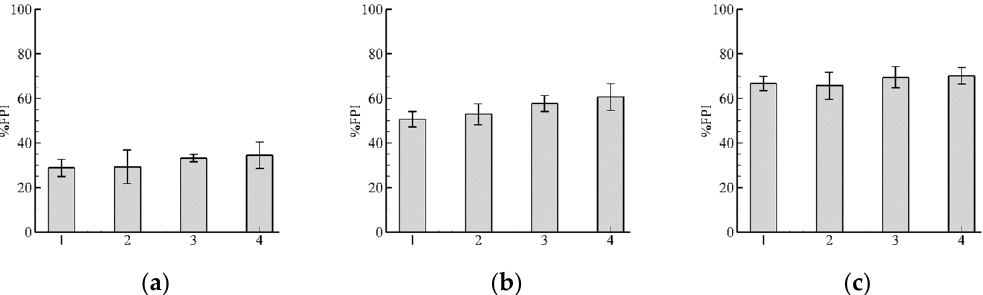
Figure 7. Results of fish passage index (%FPI) with varying C r 0 : ( a ) C r 0 = 3.0; ( b ) 6.0 and ( c ) 9.0. The numbers of the abscissa indicate bars 1, 2, 3 and 4, where 1 refers to the original algorithm, 2, 3 and 4 refer to the modified algorithm with ∆ t = 1.0, ∆ t = 0.5, and ∆ t = 0.1 s, respectively. These results clearly show that increasing the initial radius in the searching algorithm leads to increases to %FPI, and hence to errors in the estimation of the fish